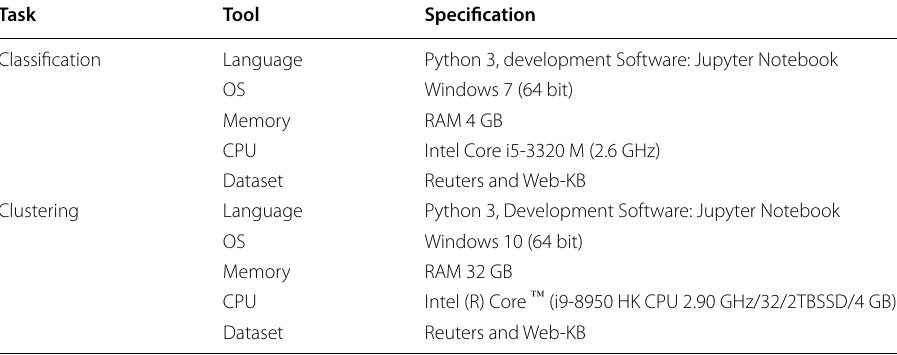
Table 1 Machine and environment description Task